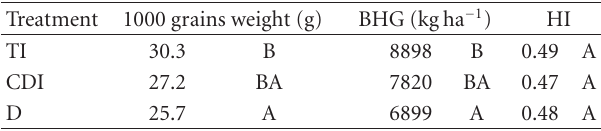
Table 9: 1000 grains weight, biomass of harvested grain (BHG) and harvest index (HI) measured during 2010 for total irrigation (TI), irrigation with controlled deficit (CDI) and dry (D)